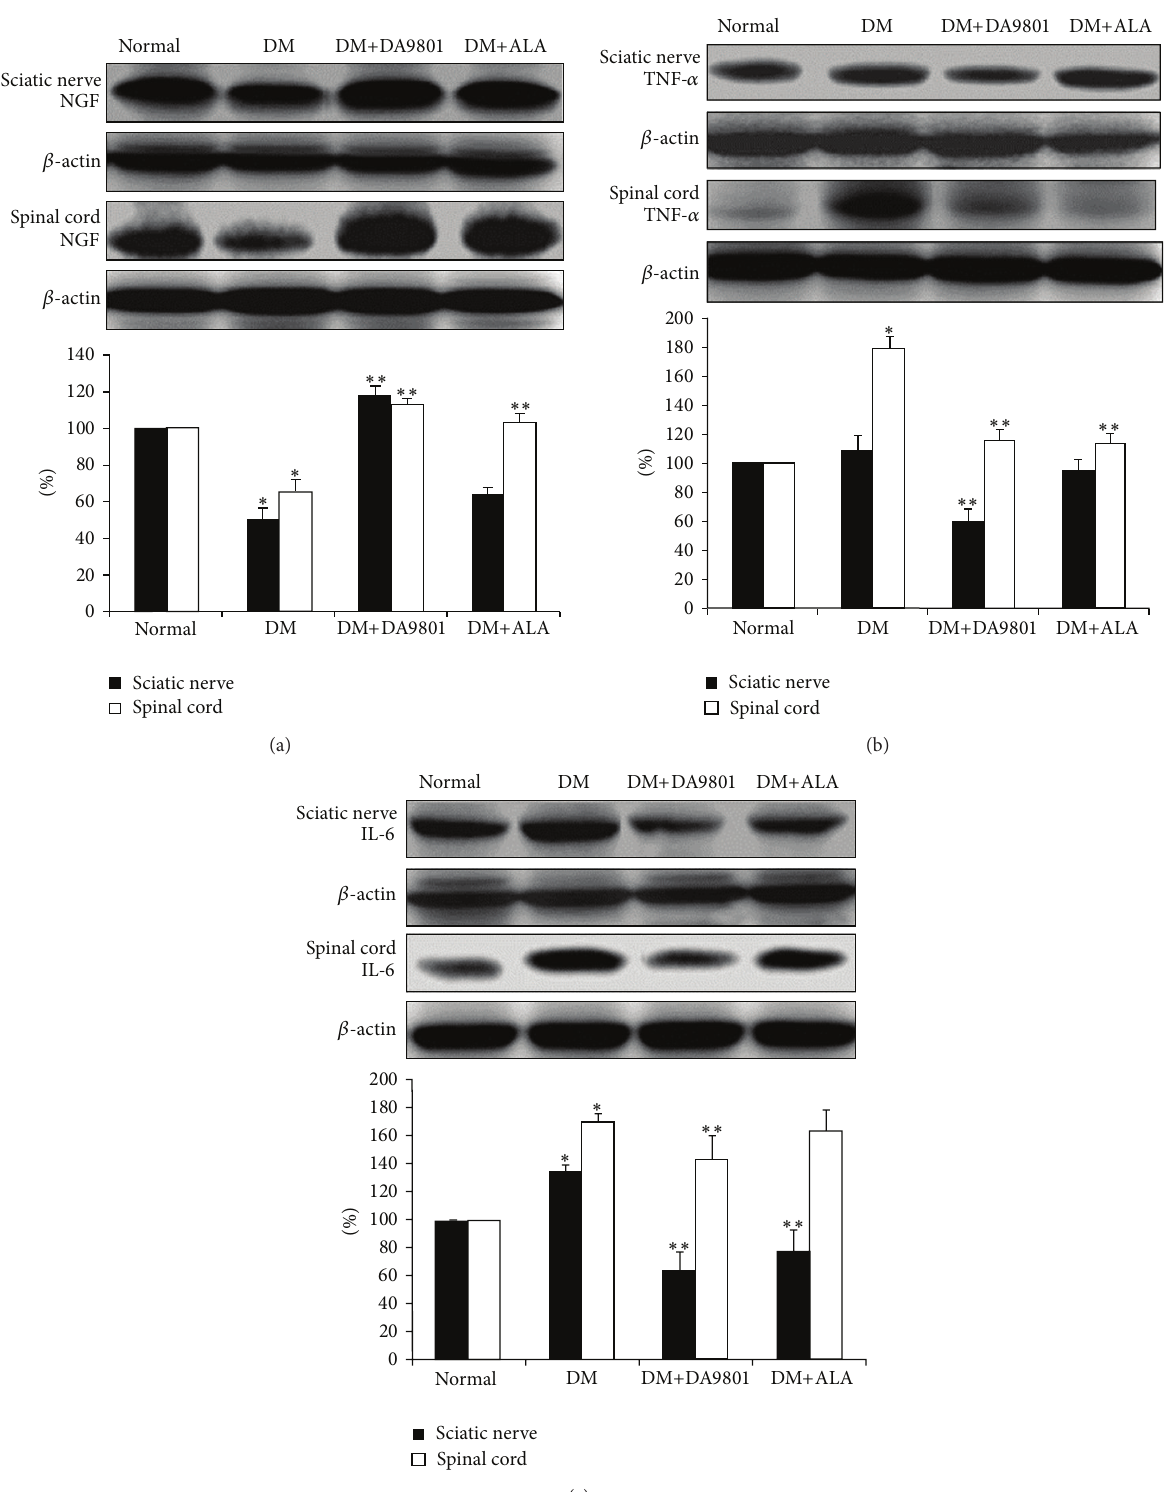
Figure 3: NGF, TNF- 𝛼 , and IL-6 levels in the sciatic nerve and spinal cord of the experimental groups. Data are presented as means ± SD. ∗ 𝑃 < 0.05 versus Normal and ∗∗ 𝑃 < 0.05 versus DM ( 𝑁 = 10 in each group). ALA: Alpha lipoic acid and DM: